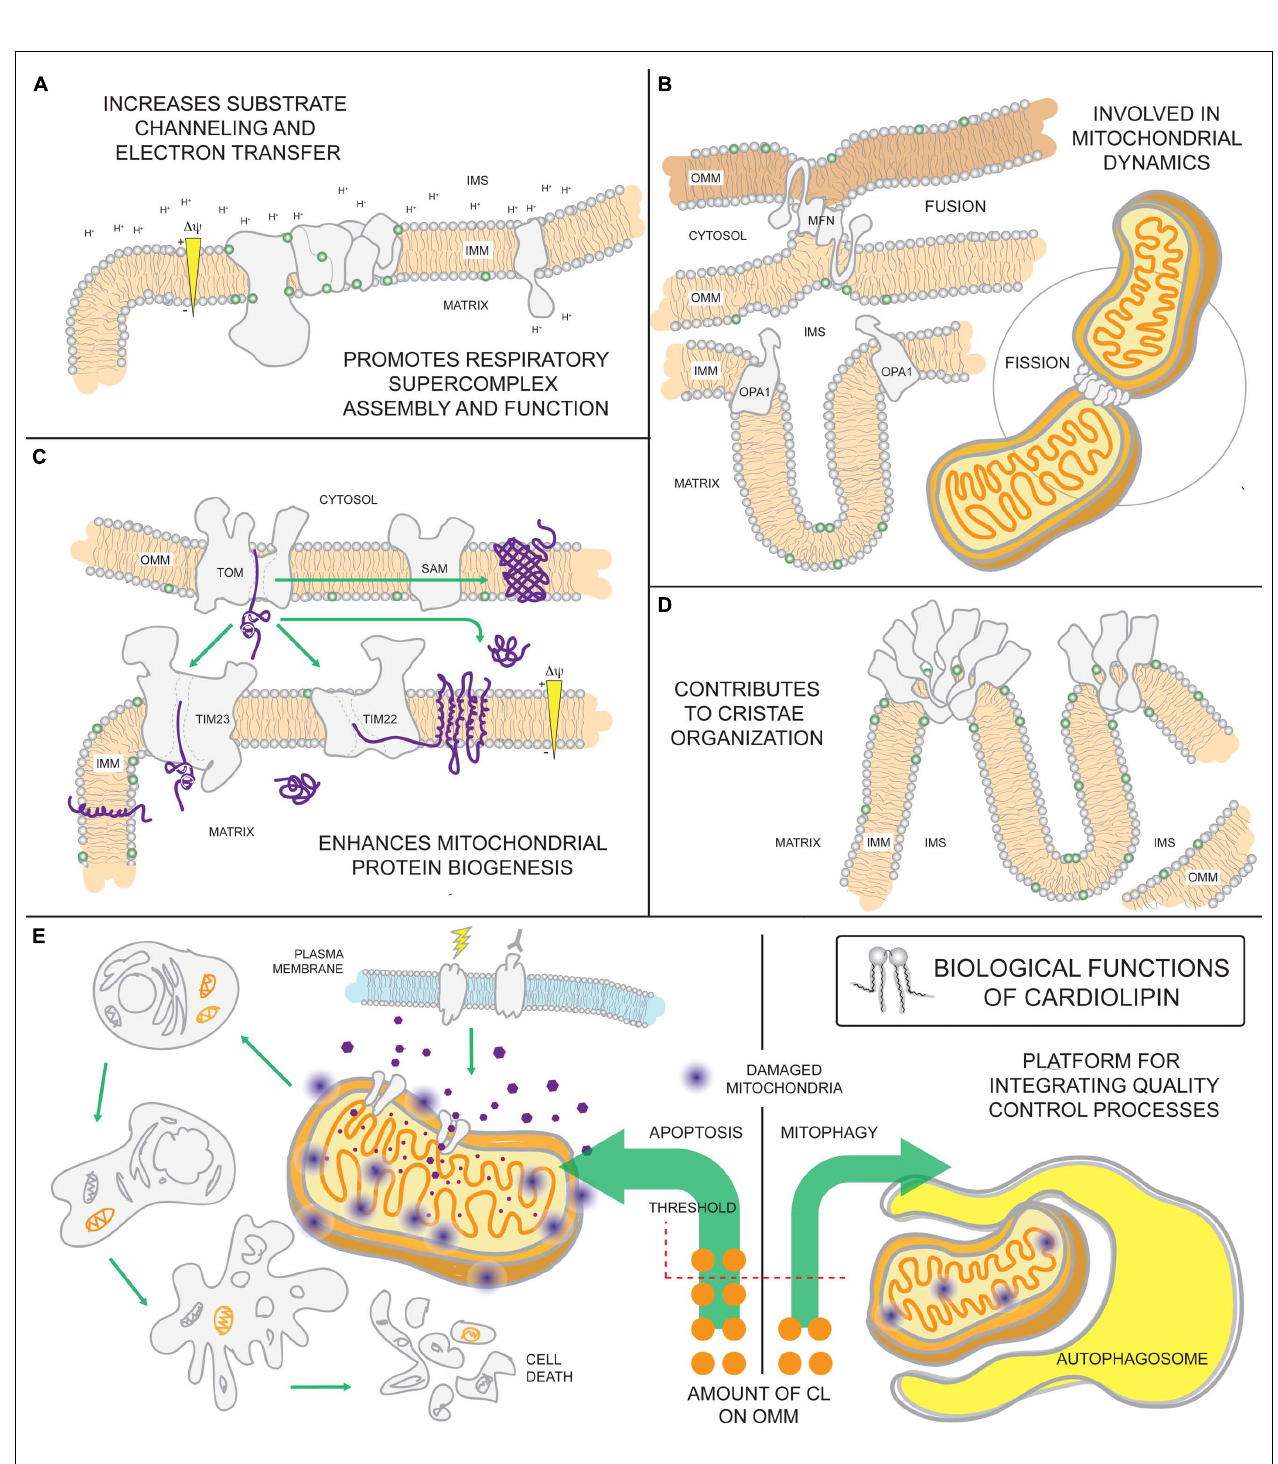
with dynamin-related GTPases that are intimately involved in fusion and fission and (C) contributes to the assembly and function of IMM and OMM translocases vital for mitochondrial biogenesis. (D) Besides enhancing OXPHOS by stabilizing SCs, CL also promotes the assembly of ATP synthase oligomers that provide a structural scaffold required for establishing the characteristic shape of mitochondrial cristae. (E) Externalization of CL on the surface of the mitochondrion is involved in signaling the execution of either mitophagy or apoptotic cell